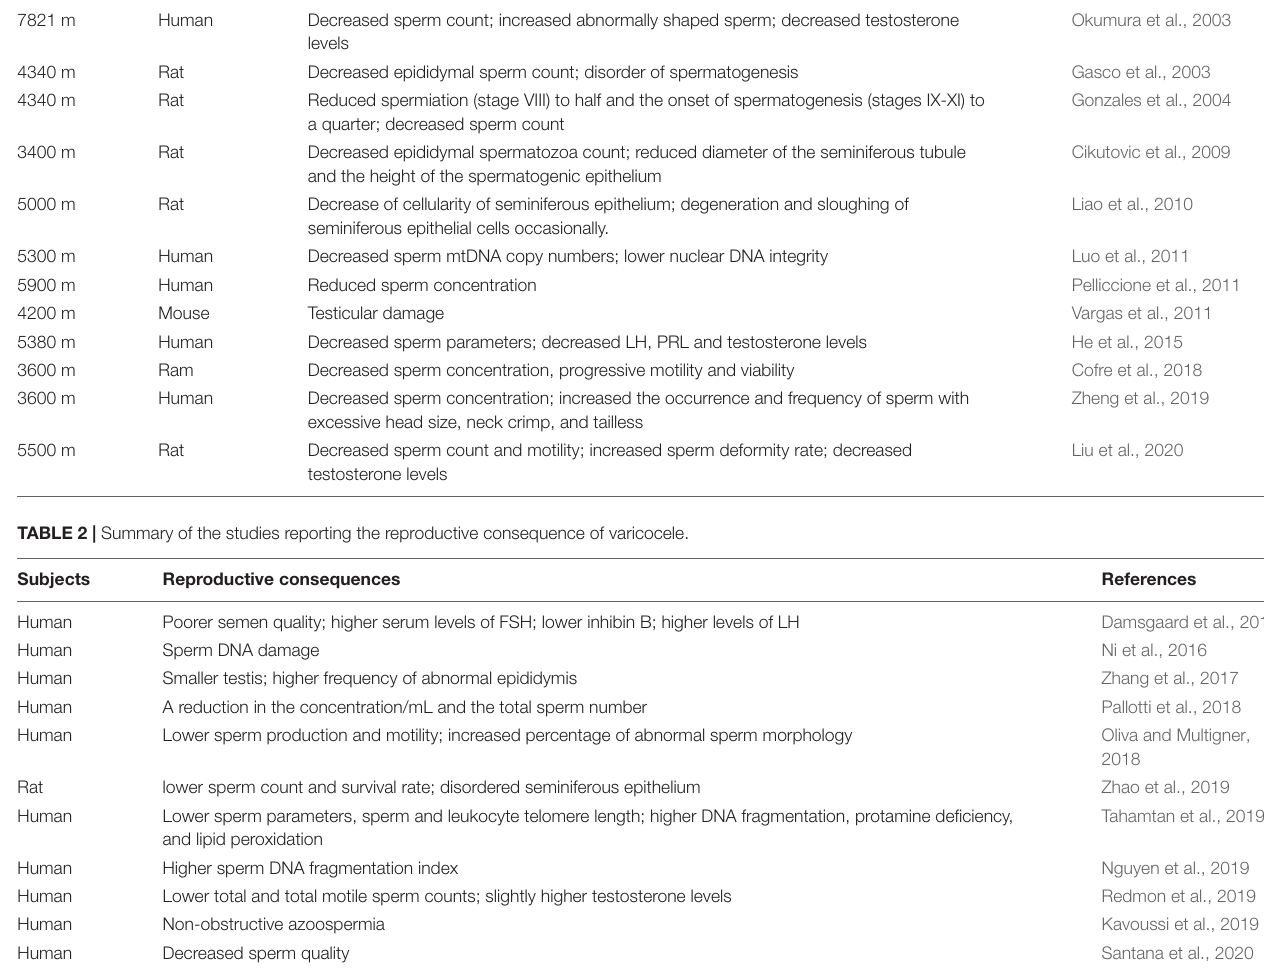
TABLE 1 | Summary of the studies reporting the reproductive consequences of high altitude. Altitude Subjects